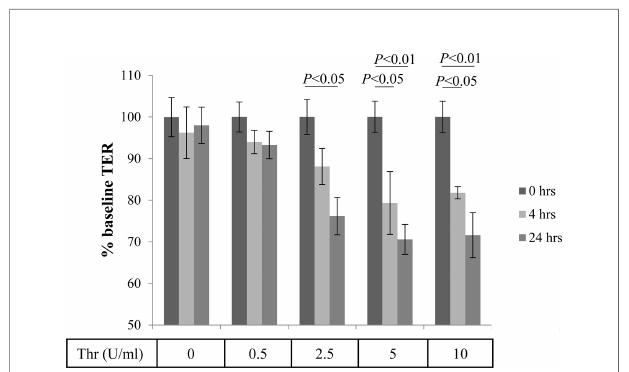
FIGURE 2 | Thrombin-mediated effects of Transepithelial Resistance (TER). Stable monolayers of ARPE-19 cells grown on transwell plates were treated with increasing concentrations of thrombin (in U/mL), which resulted in a time and dose-dependent reduction of transepithelial resistance (TER). Data are plotted as mean ± SEM; n=3 independent